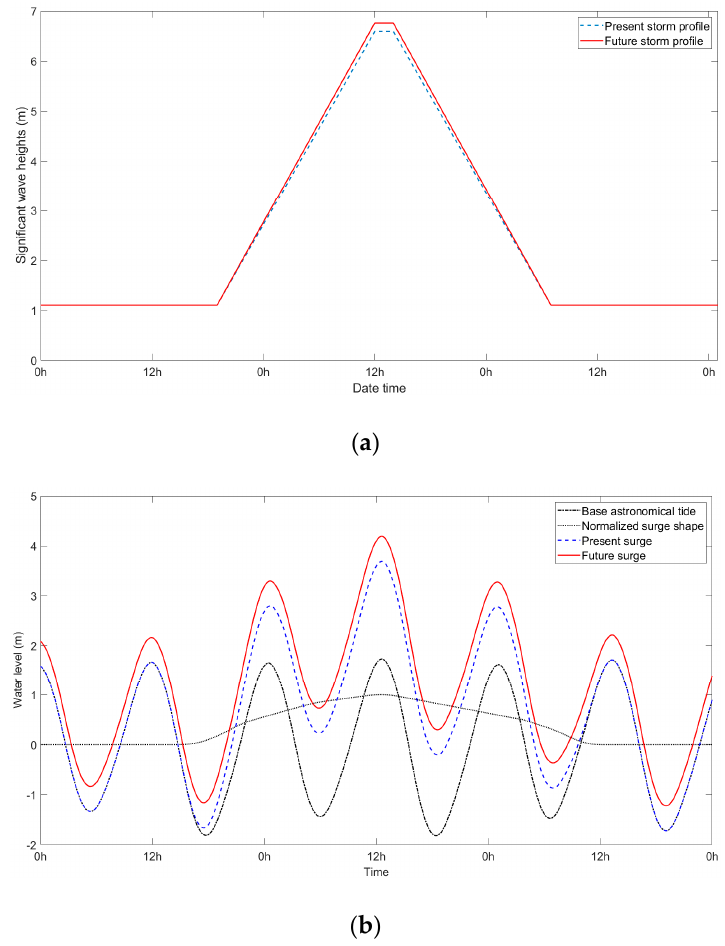
Figure 10. ( a ) Idealized present and future storm profiles, ( b ) tide and surge conditions used for model simulation. The worst-case scenario where storm peaks on the highest tide was considered. The surge profile was developed based on the normalized surge curve at Felixstowe, located to the south of Deben Estuary (in Figure 1) (reproduced based on the data was from [51] and